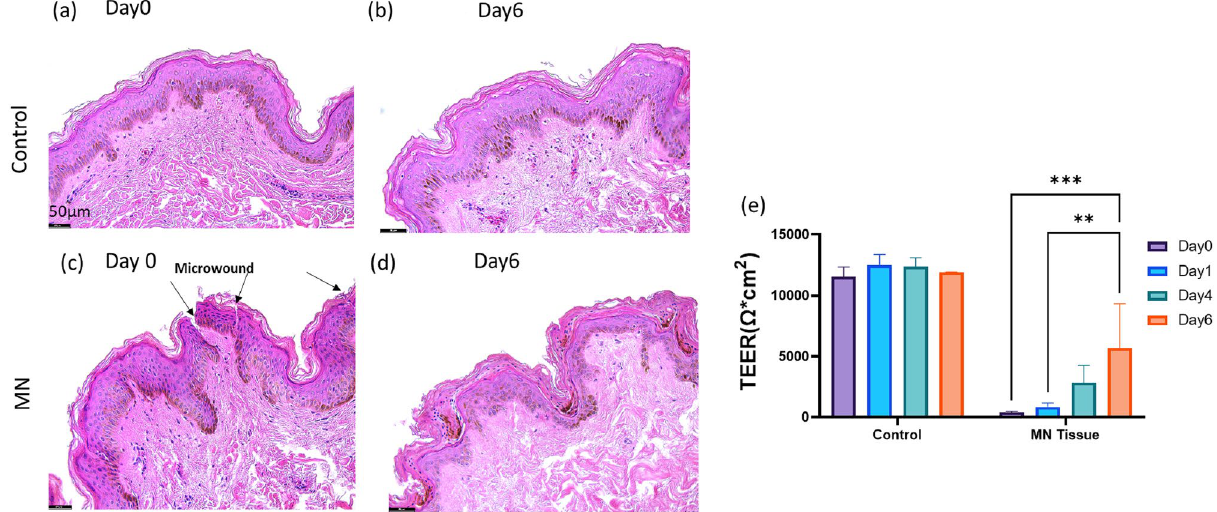
Figure 1. Characterization of ex vivo skin tissue. H&E staining of the control group tissue ( a , b ) and microneedle (MN) treated tissue on Day 0 and Day 6 ( c , d ). ( e ) The values of TEER which indicate tight junction barrier function integrity of ex vivo tissue on Day 0 and Day 6 (N = 4 biological samples, 1 donor). TEER was statistically tested using two-way ANOVA with multiple comparison Holm-Sidak test. Statistical differences are noted as ** P ≤ 0.01, *** P ≤ 0.001. Scale bar 50